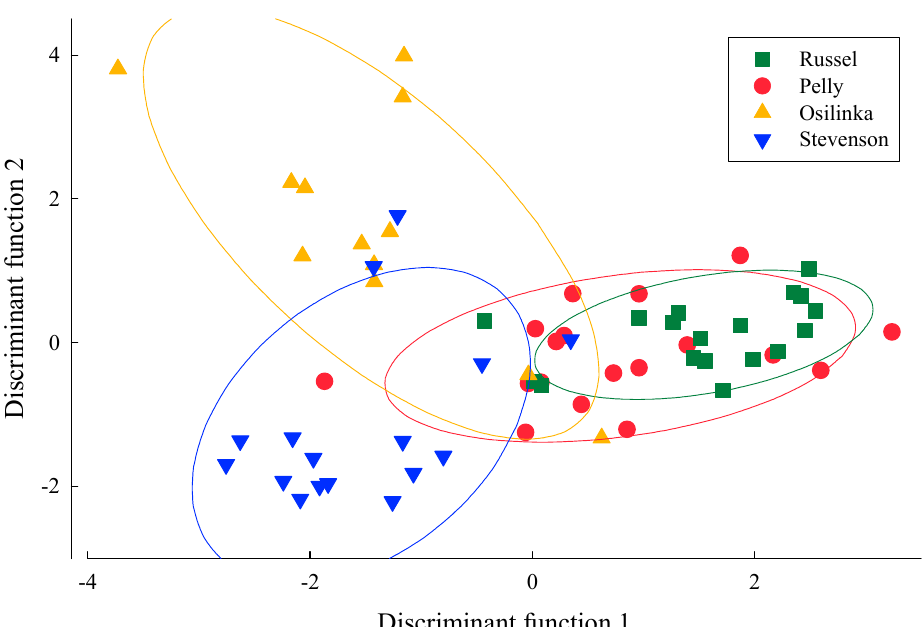
Figure 4. Discriminant function analysis using jack-knife resampling for elemental signatures from sections of otoliths that are characteristic of natal redd environments from spawning Kokanee collected from Pelly Creek, Russel Creek, Osilinka River, and Stevenson Creek. Elemental ratios included in the model were Sr, Ba, and Mn to Ca.